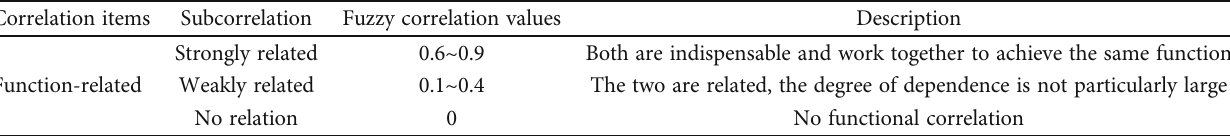
Table 3: Function